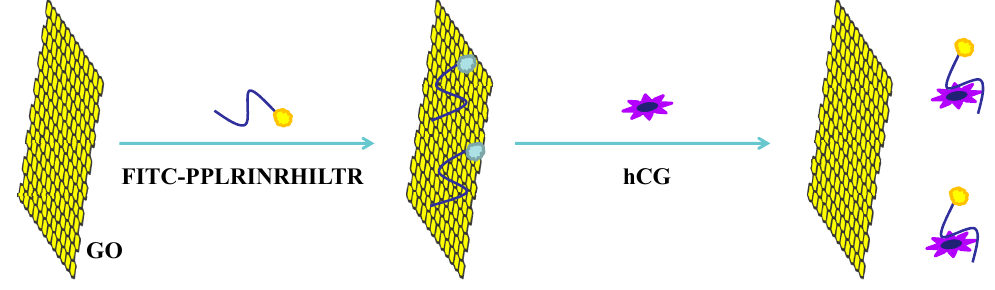
Scheme 1. Schematic illustration of the GO-based fluorescent method for hCG detection with a peptide of FITC-PPLRINRHILTR as the probe.